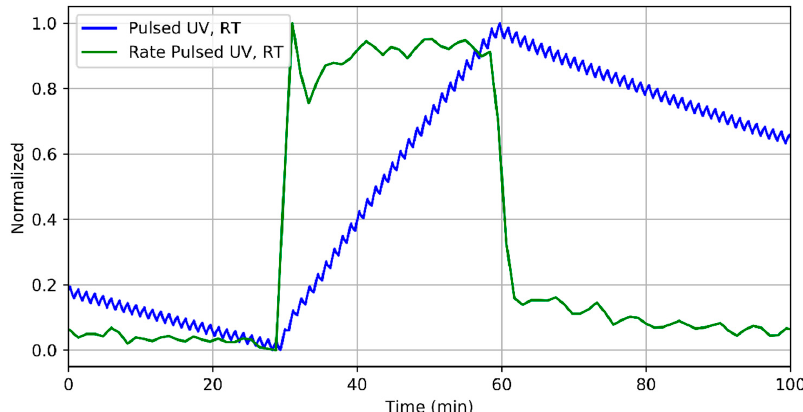
Figure 6. Detail of the sensor response to 400 ppb of NO 2 when operated at room temperature under pulsed UV light and the corresponding evaluated rate. Both curves are normalized for clarity.